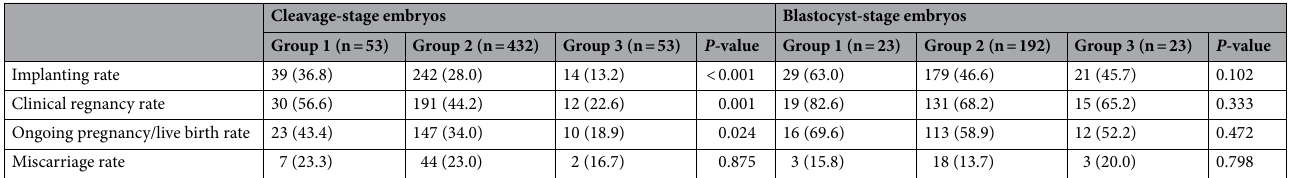
Cleavage-stage embryos Blastocyst-stage